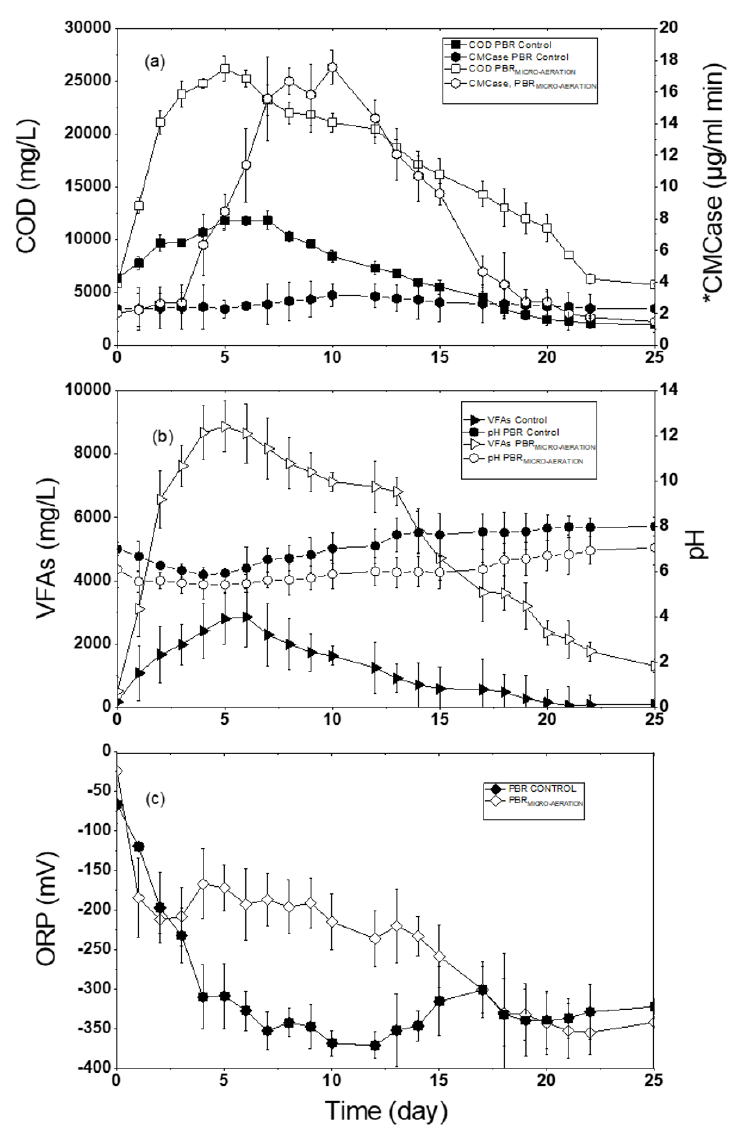
Figure 2. Packed bed reactor control reactor or with micro-aereation ( a ) chemical oxygen demand and enzymatic activity, ( b ) volatile fatty acids and pH, ( c ) oxide-reduction potential. *Carboxymethyl